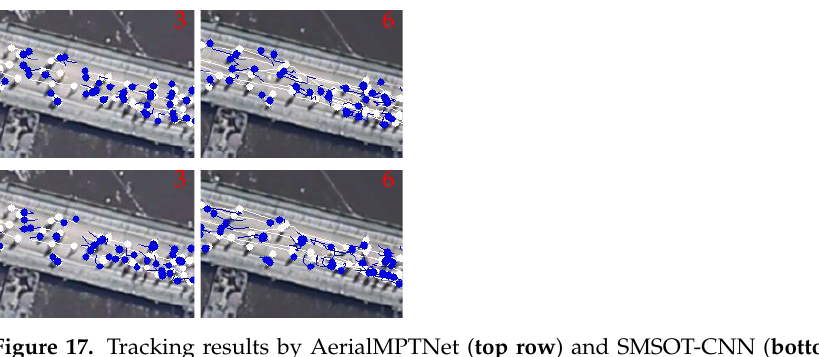
Figure 17. Tracking results by AerialMPTNet ( top row ) and SMSOT-CNN ( bottom row ) on the frames 3 and 6 of the “Witt” sequence of the AerialMPT dataset. The predictions and ground truth are depicted in blue and white, respectively.